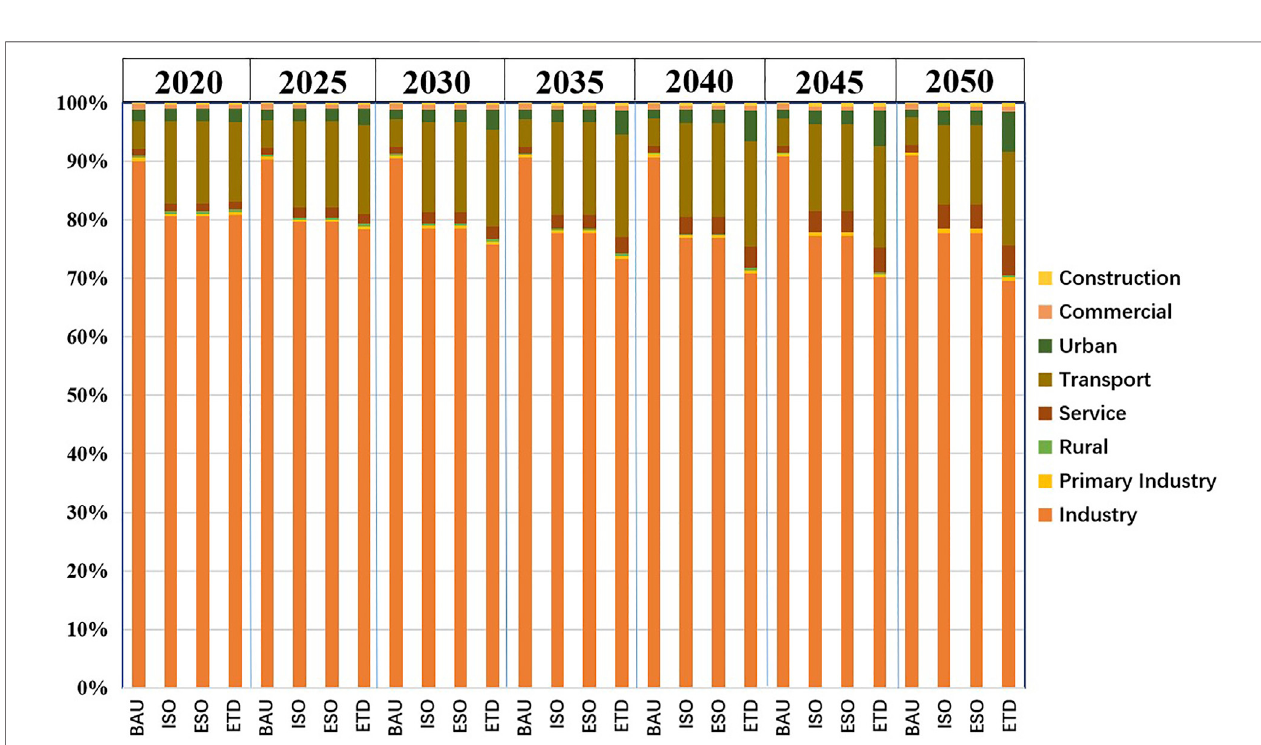
FIGURE 5 | The proportion of energy demand by sector.